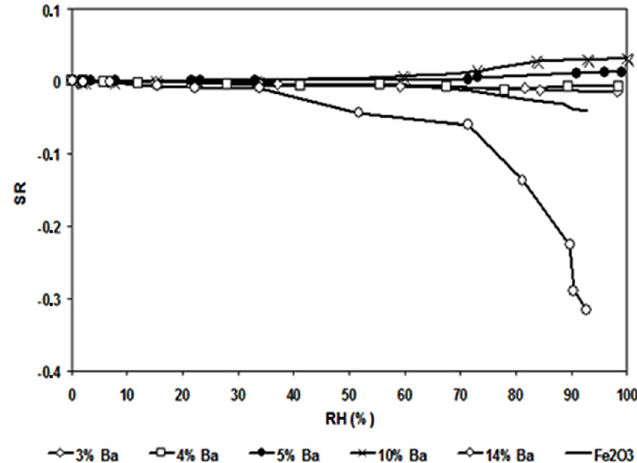
Figure 5. Humidity sensors response of various barium-doped hematite samples, after 3 min of valve switch, in function of relative humidity (RH), at 20